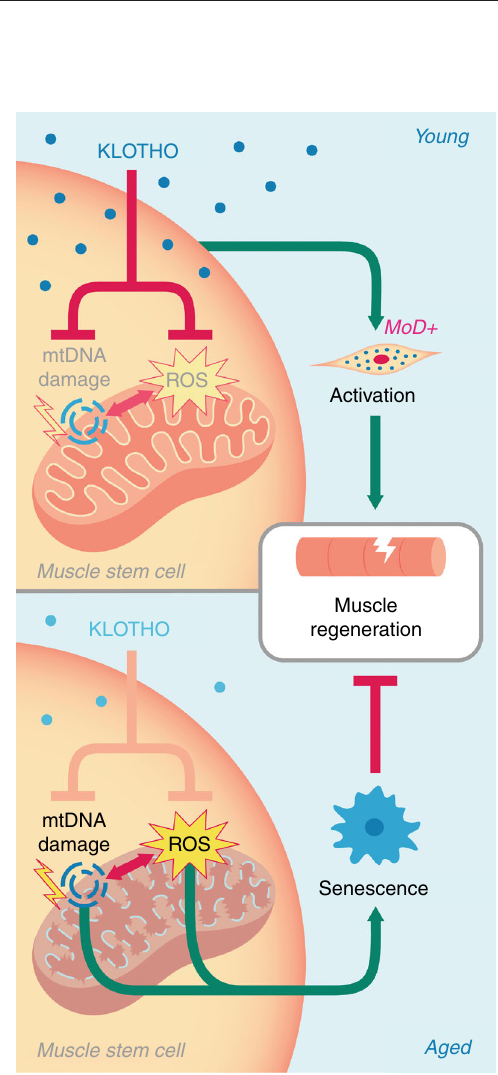
Fig. 7 Hypothesis schematic. Youthful levels of the circulating hormone α - Klotho are critical for the maintenance of muscle stem cell (MuSC) mitochondrial ultrastructure, thereby limiting mtDNA damage and mitochondrial ROS production. This maintenance of healthy mitochondria within MuSCs is required for MuSC activation and contribution to functional skeletal muscle regeneration. However, age-related declines in α - Klotho causes disrupted mitochondrial ultrastructure, increased mtDNA damage, and ROS accumulation, resulting in cellular senescence and impaired skeletal muscle